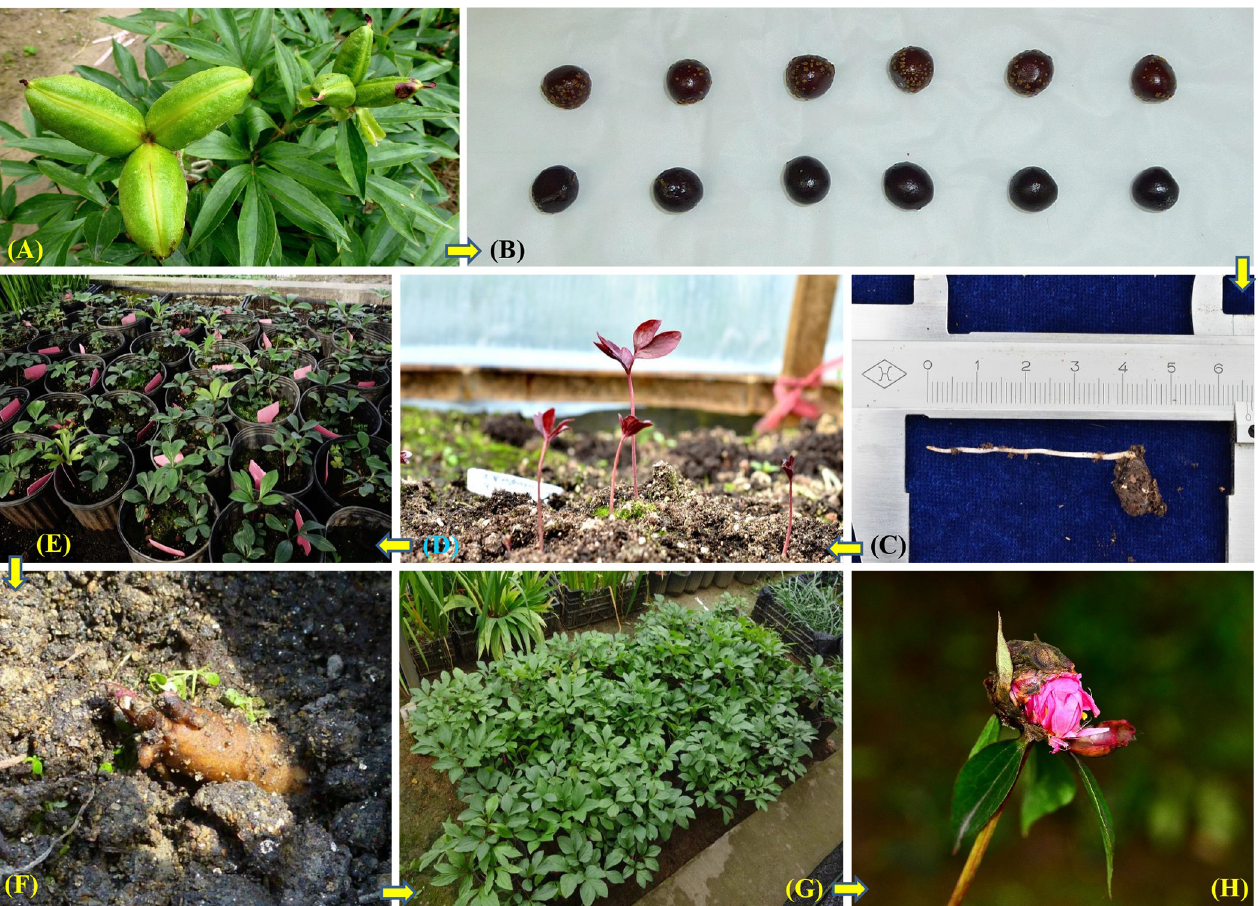
Fig 8. The important seasonal phases of hybridization and cultivation from 2013 to 2017. (A) significantly different sizes between hybrid (left) and self- pollinated (right) follicles in May 2013; (B): hybrid seeds collected in July 2013; (C): rooting of hybrid seeds in November 2013; (D): germination of hybrid seedlings in February to March 2014; (E): one-year-old seedlings grew well in May 2014; (F): tender crowns emerged in September 2014; (G): two-year-old hybrid seedlings grew vigorously in May 2015 (H): flower buds emerged after four years but were all aborted in April